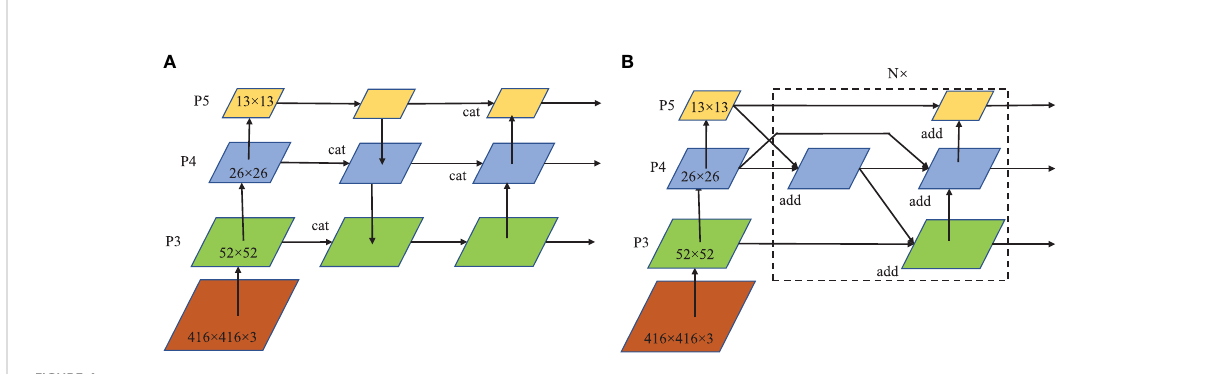
FIGURE 4 Schematic diagram of feature fusion: (A) PANet feature fusion; (B) BiFPN feature fusion.